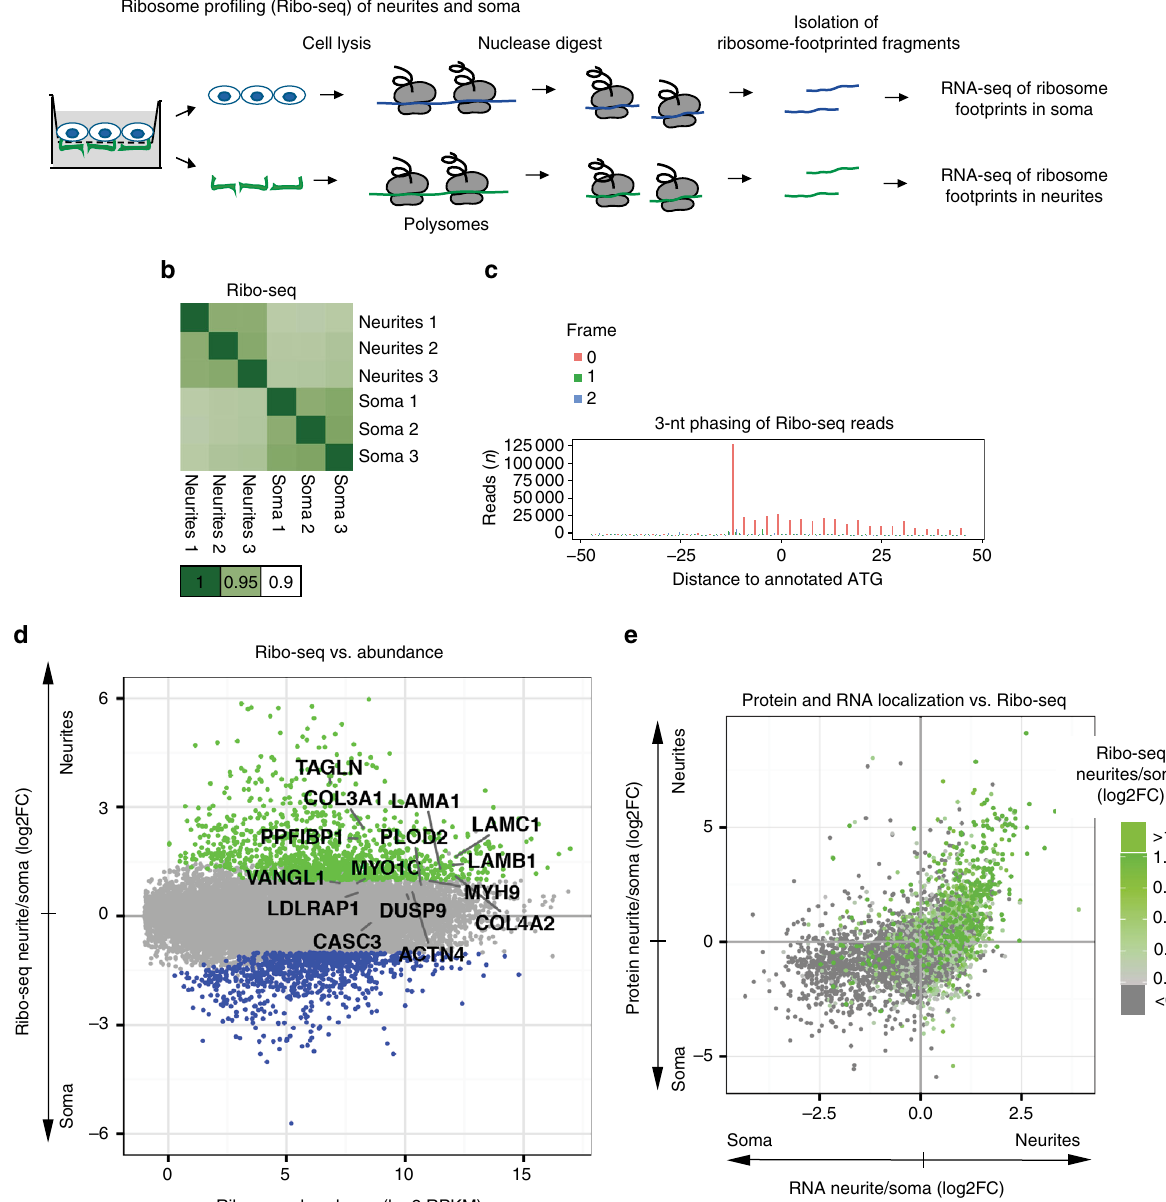
Fig. 3 Ribo-seq of neurites and soma demonstrates that neurite-enriched proteins are locally translated. a Schematic representation of local Ribo-seq. b Correlation heatmap of individual Ribo-seq libraries, prepared from neurites and soma of iNeurons (three biological replicates). c Ribo-seq reads show subcodon resolution supported by a strong bias toward the translated frame (frame 0) and 3 nt periodicity. Read length: 29 nt. d Local Ribo-seq from neurites and soma. Enrichment of Ribo-seq reads in neurite versus soma plotted against average abundance of Ribo-seq reads (RPKM mapped to CDS). Green : transcripts preferentially translated in neurites (neurites/soma log2FC > 1, P -values < 0.05). e RNA enrichment in neurites plotted against protein enrichment as in Fig. 2d, and color-coded for enrichment of Ribo-seq reads in neurites. Green : genes preferentially translated in neurites according the Ribo-seq